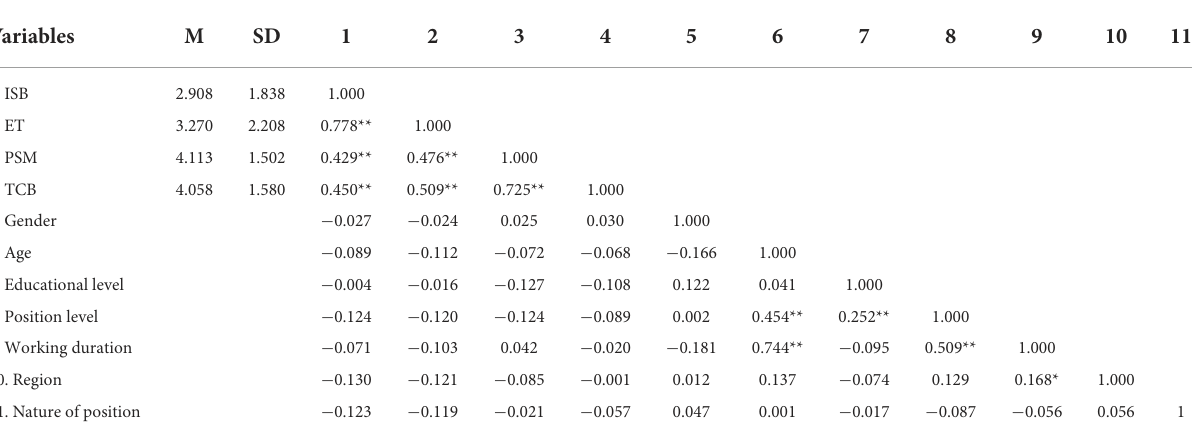
TABLE 2 Mean, standard deviations, and correlations of variables.